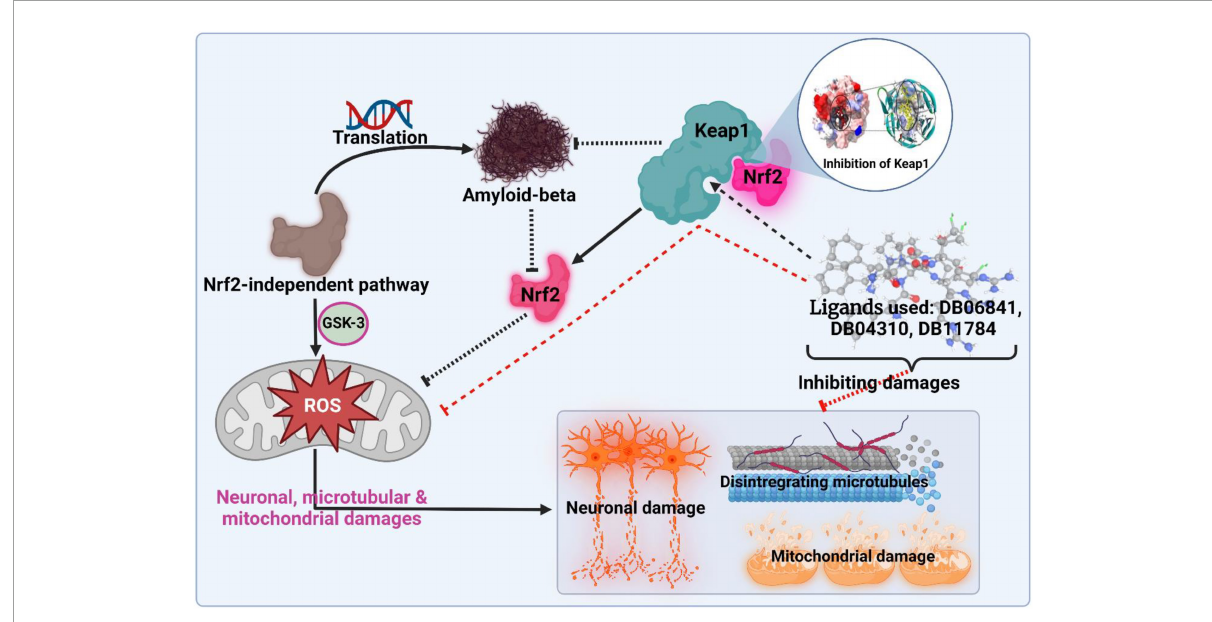
FIGURE1 Schematic presentation of the active inhibition. Adopted from